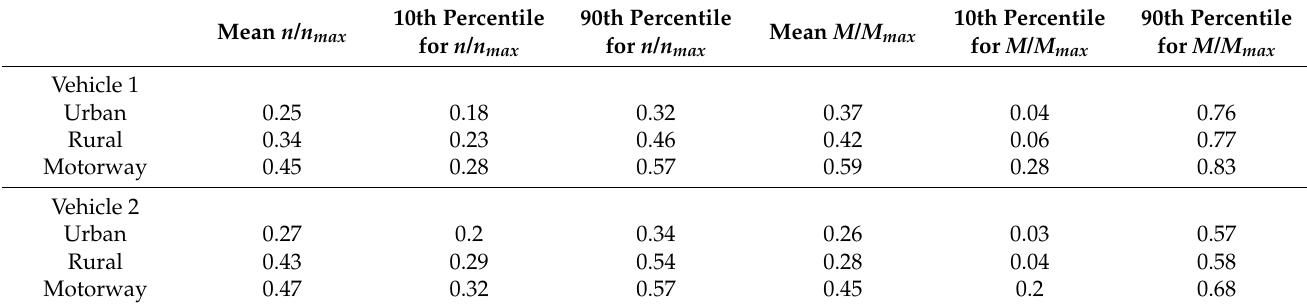
Table 4. Characteristics of the data sets in terms of recorded values of the engine speed and engine torque.